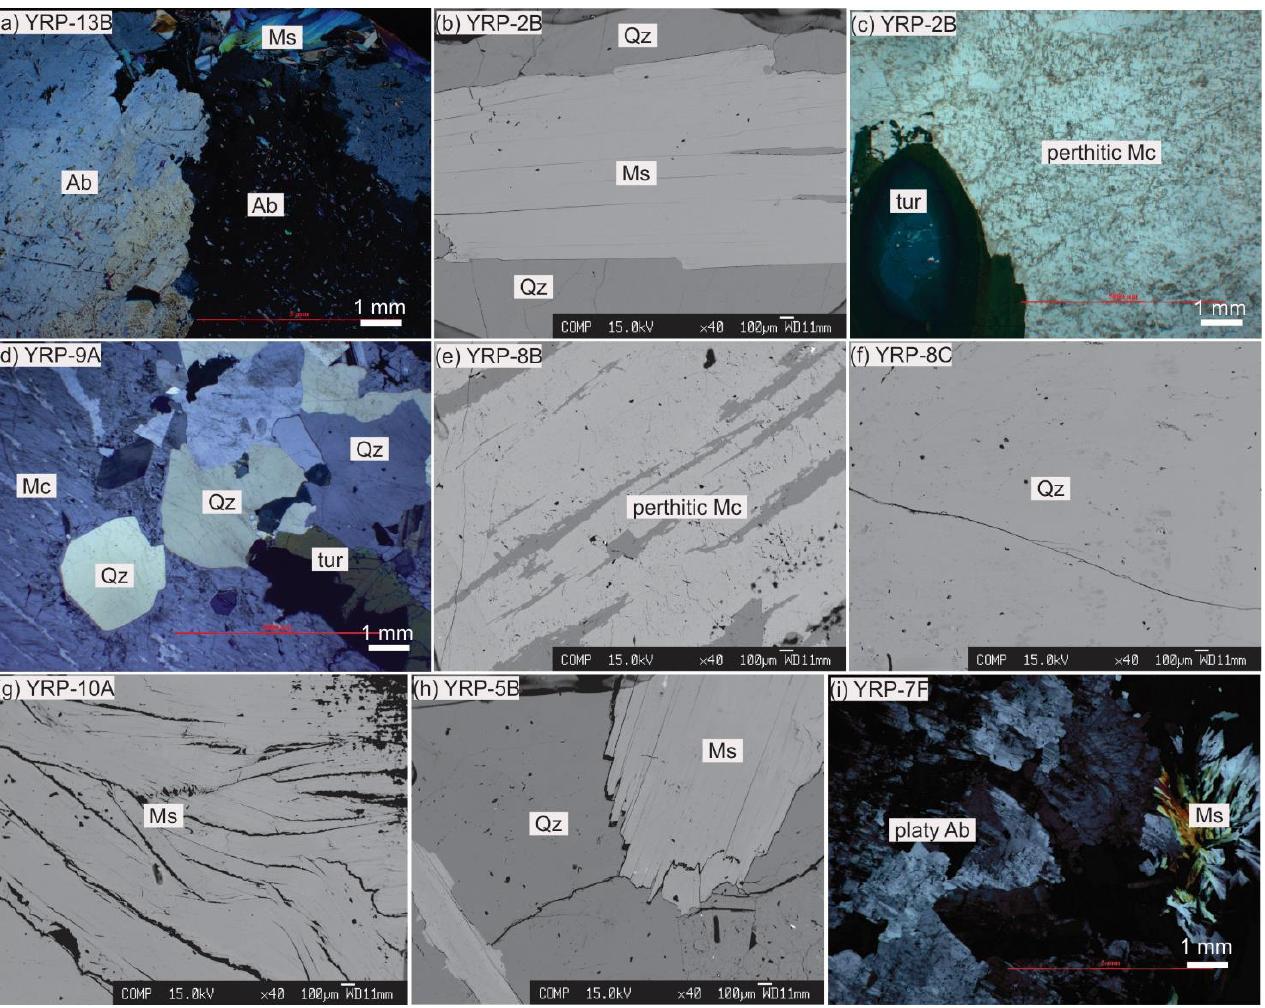
Figure 8. Photomicrographs and BSE images of alkali feldspar, muscovite, and quartz from the Yamrang Pegmatite. ( a ) Assemblage of albite, primary muscovite, and secondary mica overgrowing albite from zone 1 under cross-polarized light; ( b ) BSE image of homogeneous muscovite and quartz from zone 2; ( c ) Perthitic microcline and tourmaline from zone 2 under plane-polarized light; ( d ) Assemblage of perthitic microcline, anhedral quartz, and tourmaline from zone 3 under cross- polarized light; ( e ) BSE image of perthitic microcline from zone 4; ( f ) BSE image of homogeneous quartz from the core; ( g ) BSE image of muscovite sampled near core zone 4; ( h ) BSE image of miarolitic homogeneous muscovite and quartz; ( i ) Platy albite and muscovite books assemblage from miaroles under cross-polarized light. Mineral abbreviations: Ab, albite; Mc, microcline; Ms, muscovite; Qz, quartz; Tur, tourmaline. Mineral abbreviations are after